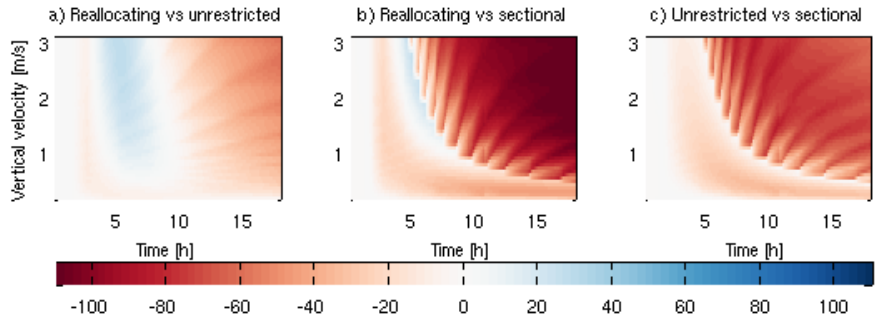
Figure 9: Number size distribution plots illustrating the major differences between the models. An example of a critical diameter for a midrange updraft velocity is plotted with dashed line on the distributions.